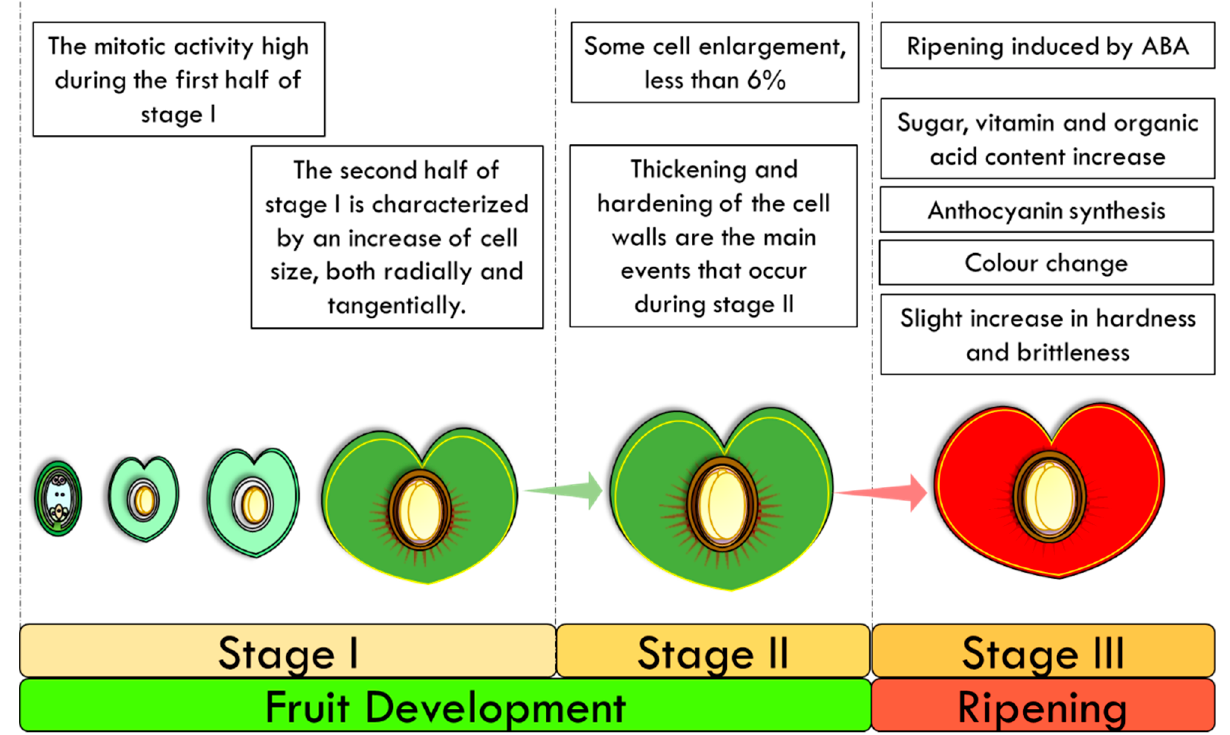
Figure 4. Fruit Ripening in the cultivated cherry. After an initial exponential phase (Stage I) a plat- eau phase occurs (Stage II), which is followed then by a second exponential phase (Stage III) until the complete ripening of the fruit.